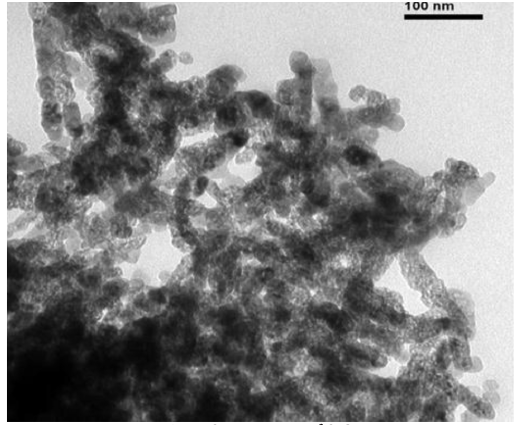
Fig 2. SEM image of SiO